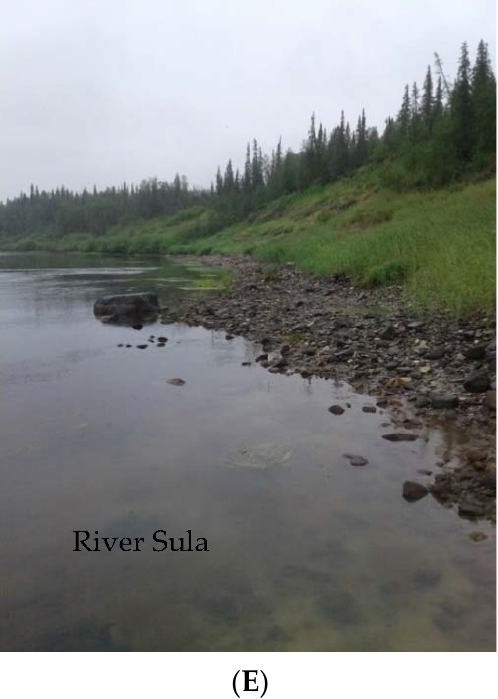
Figure 7. Mollusk shells were collected from the following outcrops: ( A ): Vastyansky Kon’, ( B ): Khongurei, ( C ): 10 km northwest of the village Oksino on the river Pechora, ( D ): Bychye on the Peza River, ( E ): Sula River.